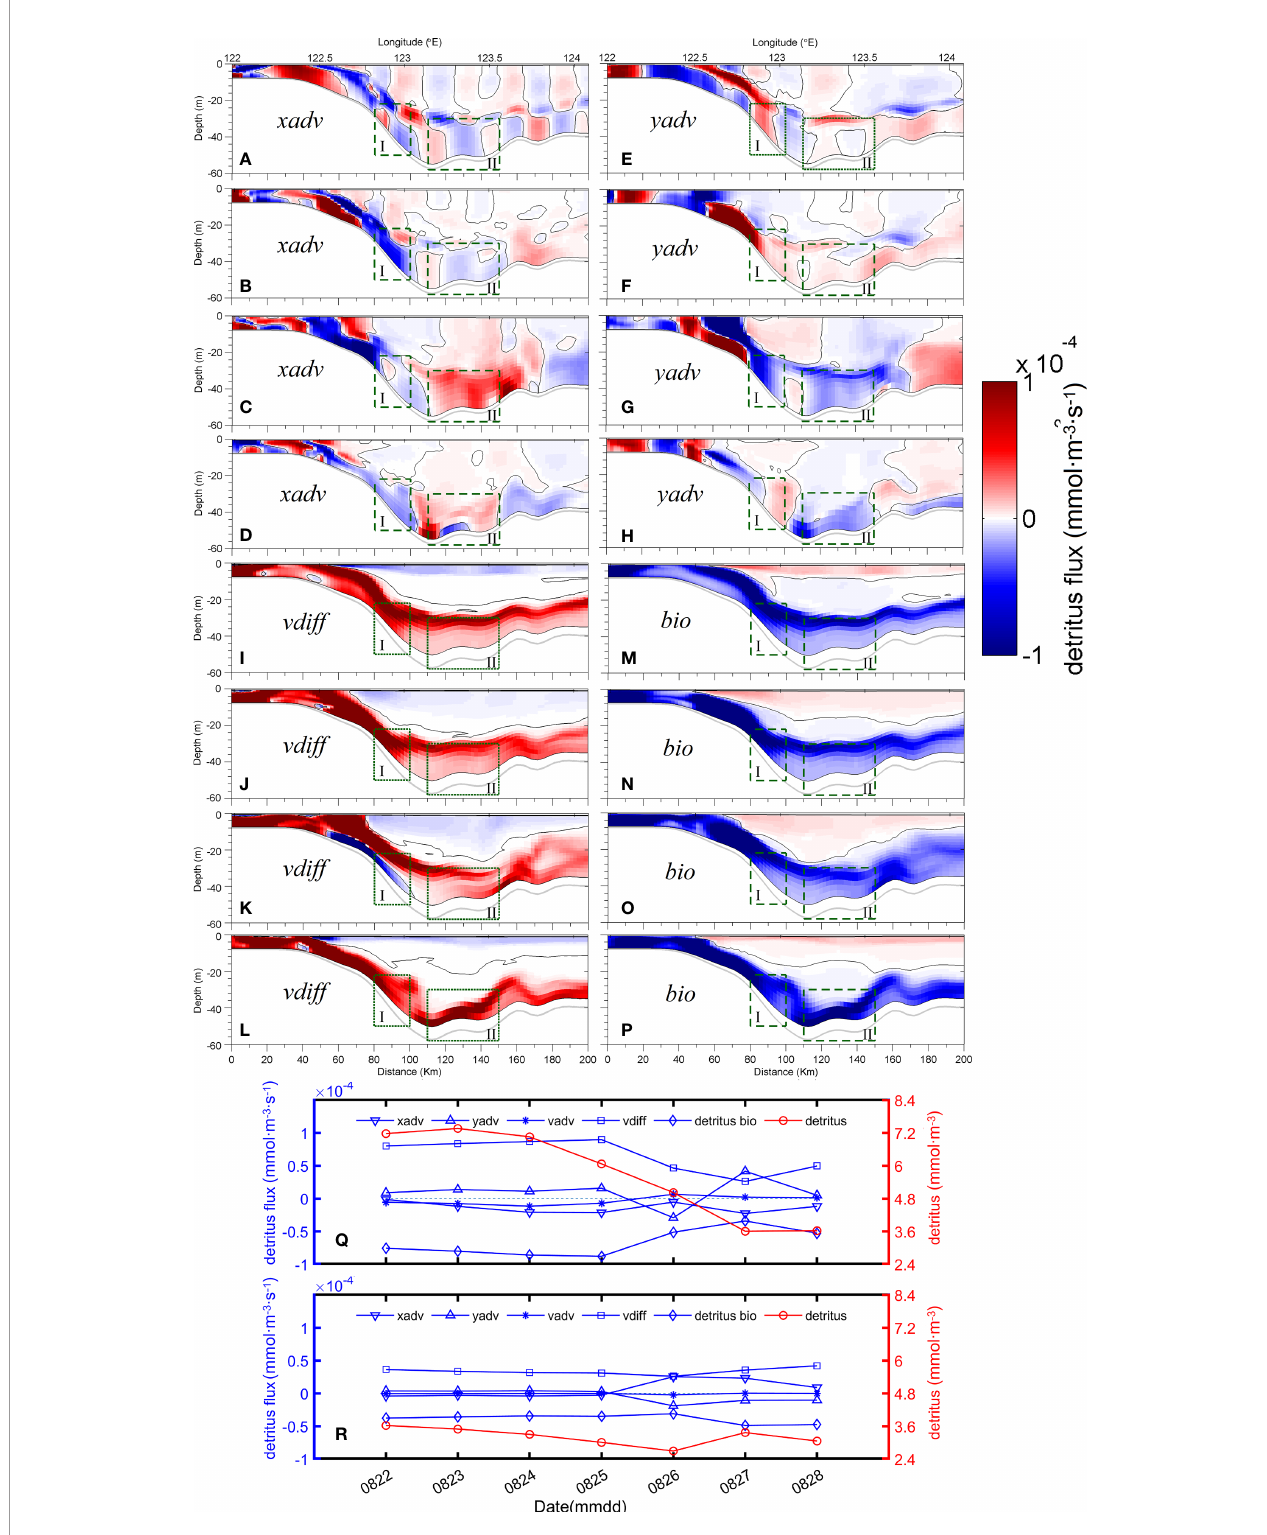
FIGURE 14 | The diagnostic terms for xadv , yadv , vdiff , and bio in terms of detritus at the 31°N transect on August 22 (A – D) , 25 (E – H) , 26 (I – L) , and 28 (M – P) , 2020. Regions I and II are marked by dashed rectangles in Panels (A – P) . Panels (Q, R) are time series of diagnostic terms in terms of detritus averaged in Regions I and II,